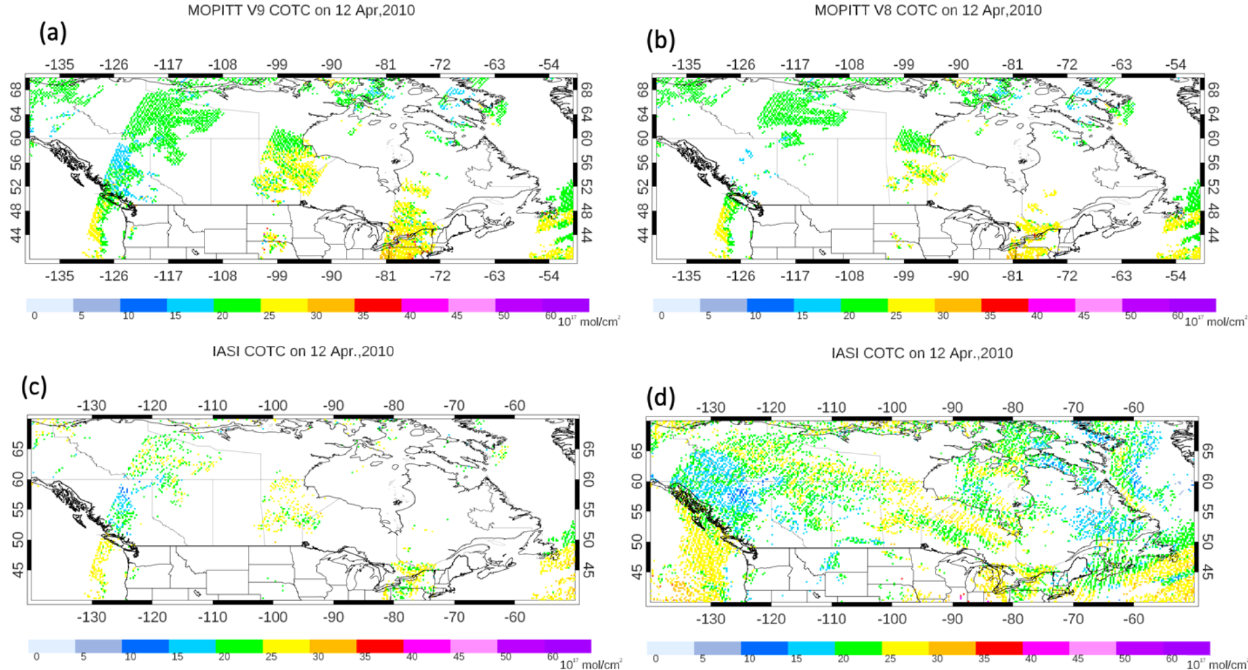
Figure 12. The same as Fig. 10 but for 12 April